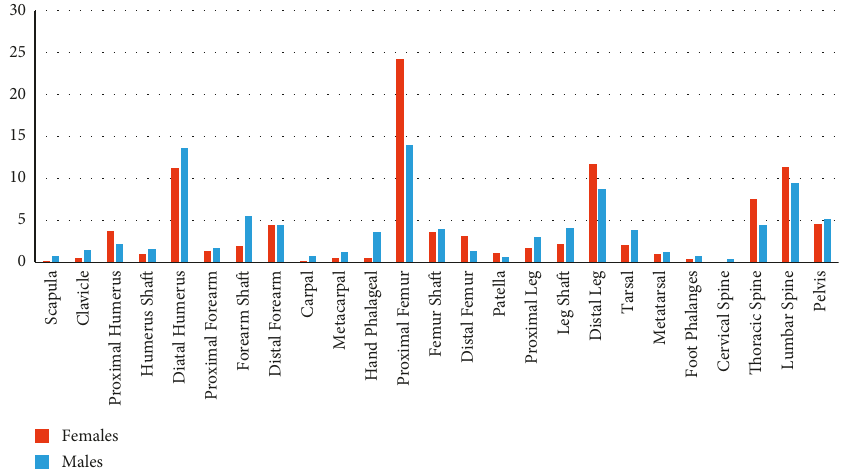
Figure 6: Fractures distributions according to